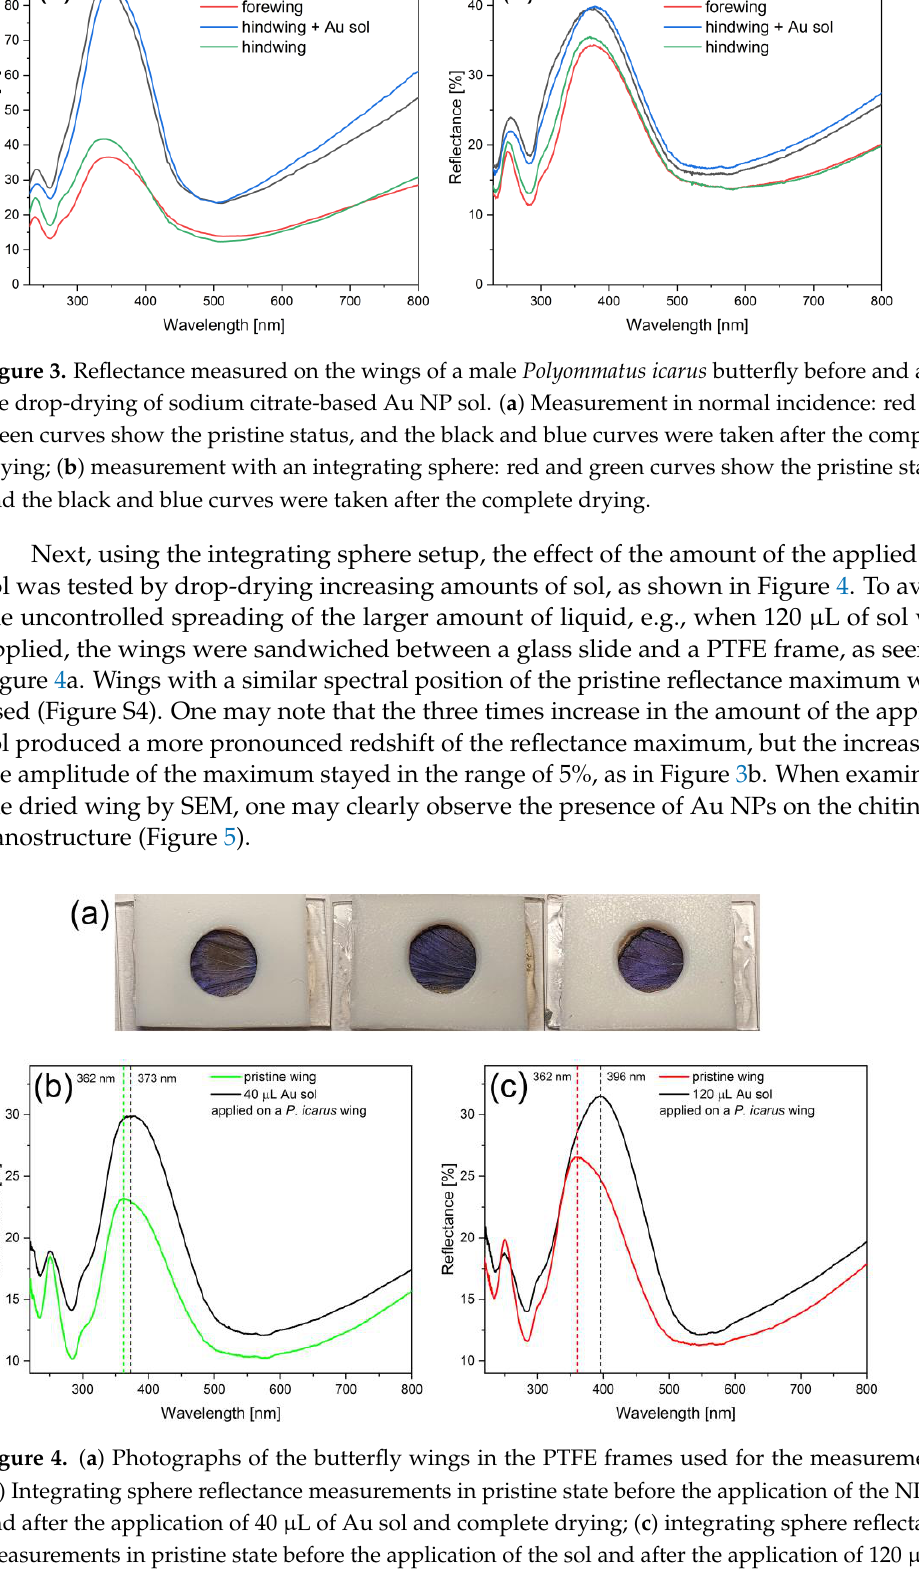
Figure 4. ( a ) Photographs of the butterfly wings in the PTFE frames used for the measurements; ( b ) Integrating sphere reflectance measurements in pristine state before the application of the NP sol and after the application of 40 µL of Au sol and complete drying; ( c ) integrating sphere reflectance measurements in pristine state before the application of the sol and after the application of 120 µL of Au sol and complete drying.